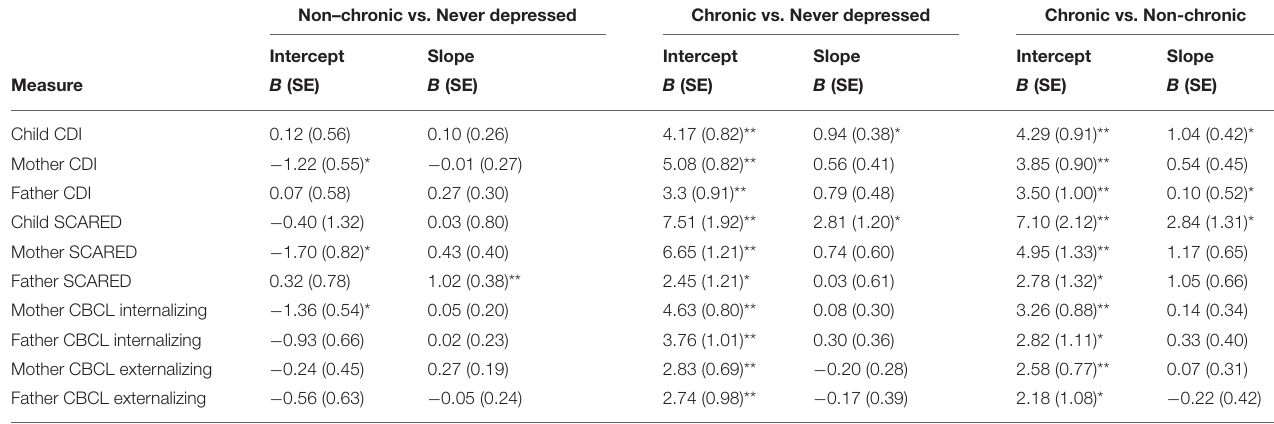
TABLE 3 | Multi-level models using maternal depression at age 3 to predict symptom outcomes across subsequent waves using the life course approach. Non–chronic vs. Never depressed Chronic vs. Never depressed Chronic vs. Non-chronic Intercept Slope Intercept Slope Intercept Slope Measure